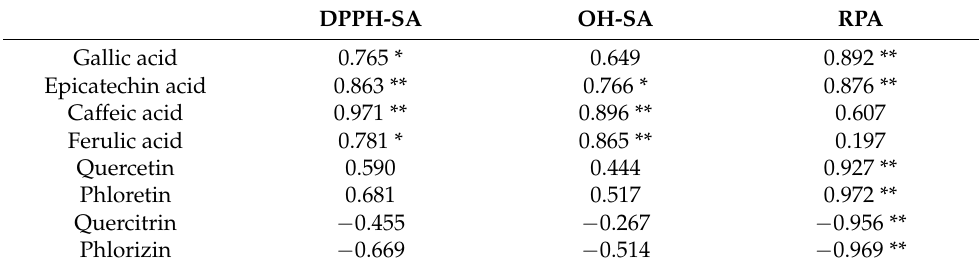
Table 2. Correlation between phenolic profiles in apple pomace after fermentation and antioxidant activities. DPPH-SA OH-SA RPA Gallic acid 0.765 * 0.649 0.892 ** Epicatechin acid 0.863 ** 0.766 * 0.876 ** Caffeic acid 0.971 ** 0.896 ** 0.607 Ferulic acid 0.781 * 0.865 ** 0.197 Quercetin 0.590 0.444 0.927 ** Phloretin 0.681 0.517 0.972 ** Quercitrin − 0.455 − 0.267 − 0.956 ** Phlorizin − 0.669 −